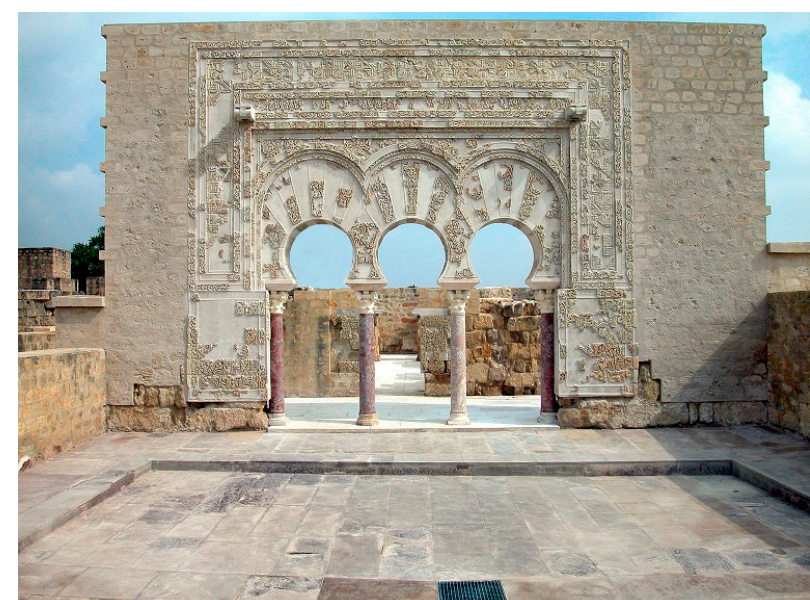
Figure 10. House of Ja c far. Façade (Photo M. Pijuán © Conjunto Arqueológico de Madinat al-Zahra).